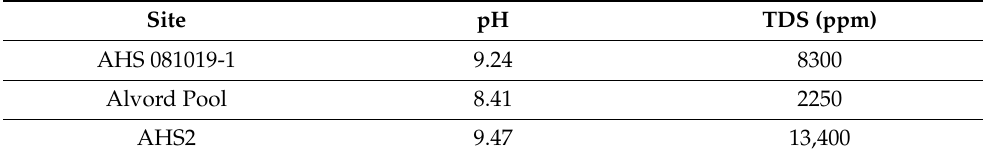
Table 1. Total dissolved solids (TDS) and pH measurements of spring discharge in and around the plume. AHS081019-1 was collected from the plume center, Alvord Pool was collected from a valley-wall spring pool, and AHS2 was collected from spring discharge upslope from the pool. Site pH TDS (ppm) Alvord Pool